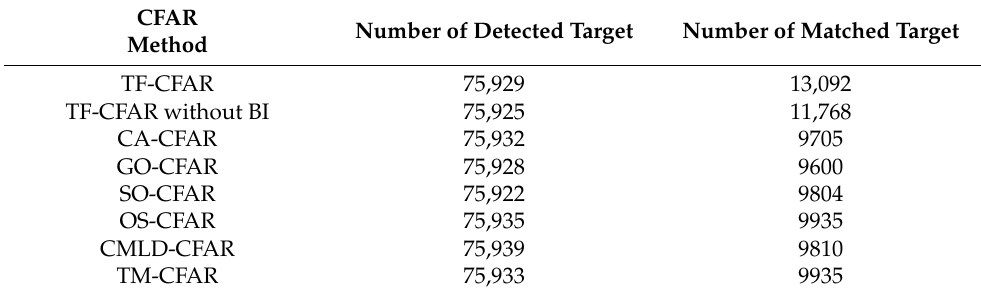
Table 4. Comparison between matched targets under approximately equal numbers of detected targets on 25 September